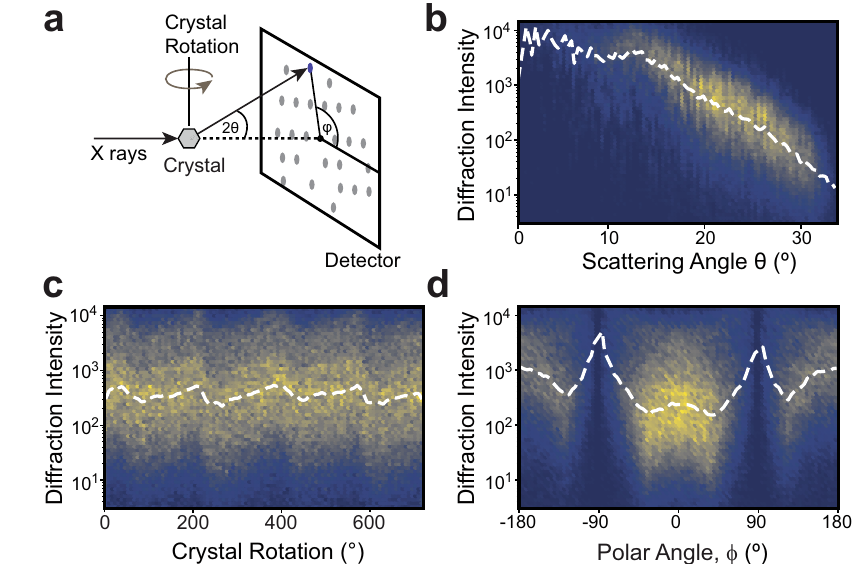
Fig. 1 | The intensity of observed re fl ections depends on physical factors. a Geometry of a conventional diffraction experiment: a crystal (shown as a hexa- gon)scattersanincidentX-raybeamandyieldsapatternofre fl ections(grayspots) onadetector.Threemetadataofthemeasurementsareindicated:scatteringangle 2 θ , crystal rotation angle, and polar angle, ϕ . b-d depict the dependence of the observed intensity distributions on these metadata for a hen egg-white lysozyme dataset. The 2-dimensional histograms show the number of counts in each of bins